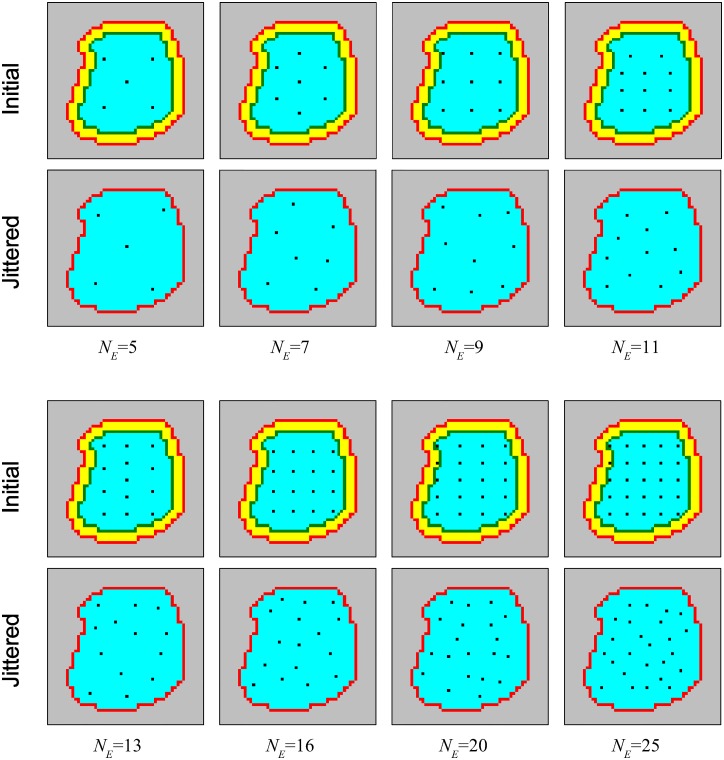
Examples of random Gaussian mean placements for different NE from the manually designed initial points (black points).The red pixels represent the outer border of the active region of the image, and the yellow pixels represent a forbidden region which is 3 pixels thick. The jittered mean points were restricted to be placed inside the inner region (including the green pixels) which is surrounded by the inner border (green).